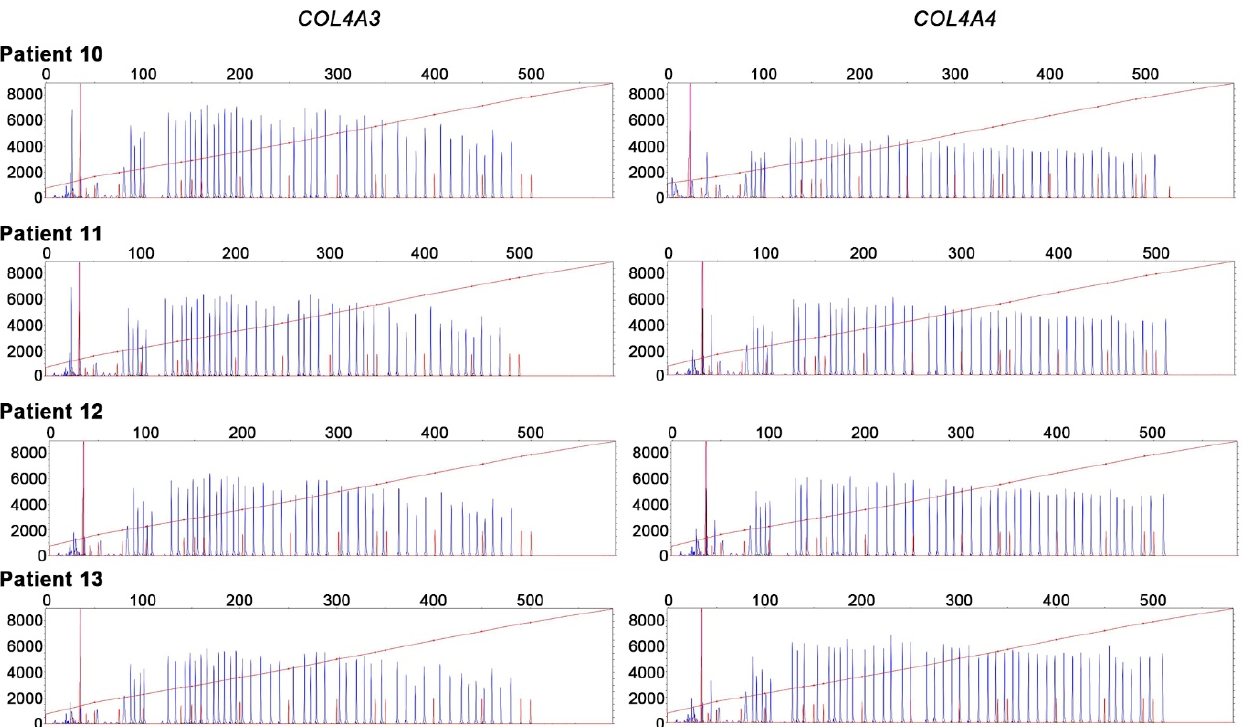
Figure 2. Multiplex ligation-dependent probe amplification (MLPA) analyses of COL4A3 and COL4A4 . MLPA analyses showed negative results in four patients with no apparent variants for Sanger sequencing.